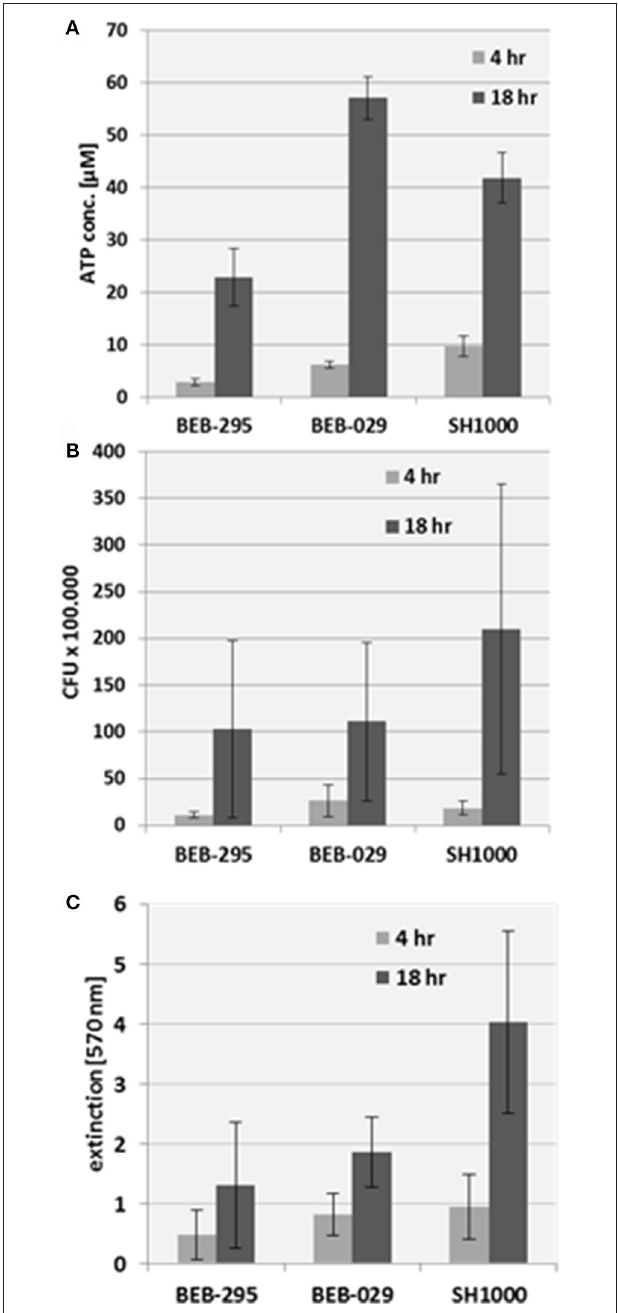
FIGURE 3 | Biofilm quantification on the control surface polystyrene. (A) Mitochondrial ATP concentration, (B) CFU count, (C) Crystal violet staining.